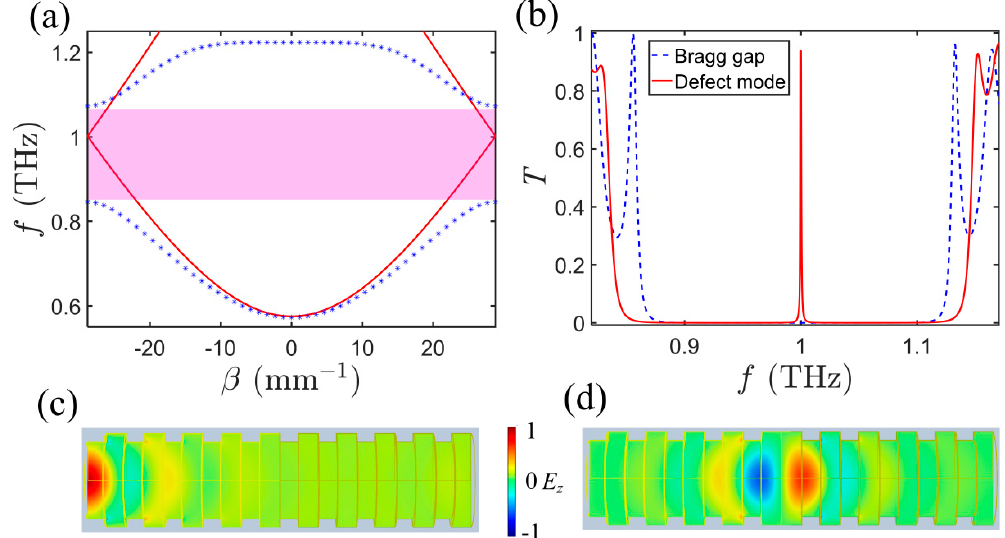
Figure 1. A schematic diagram of the Bragg ( a ) and Bragg defect ( b ) structures. The yellow curves represent the pipe wall of gold while the gray-green indicates the LCs (E7) filling the metal waveguide. The darker, orange-outlined section illustrates the inserted defect in the Bragg structure with length L .